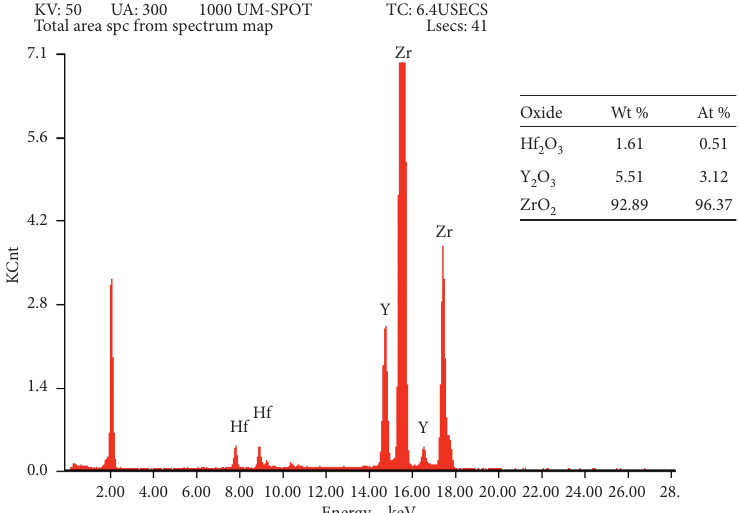
Figure 12: Component analysis of the microwave-sintered sample by